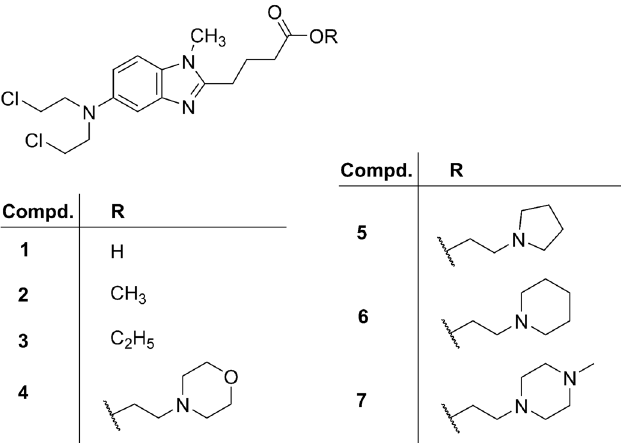
Fig 1. Structures of bendamustine (1) and the bendamustine esters 2 – 7.